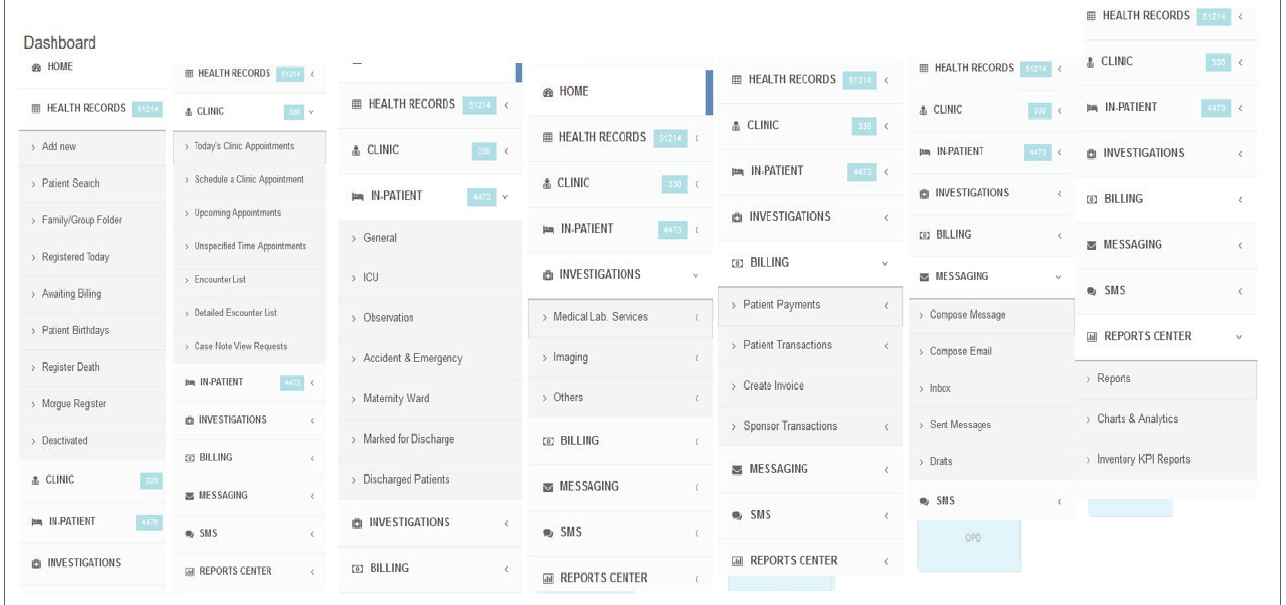
FIGURE 6: The screenshot dashboard of interface of various departments using Electronic Health